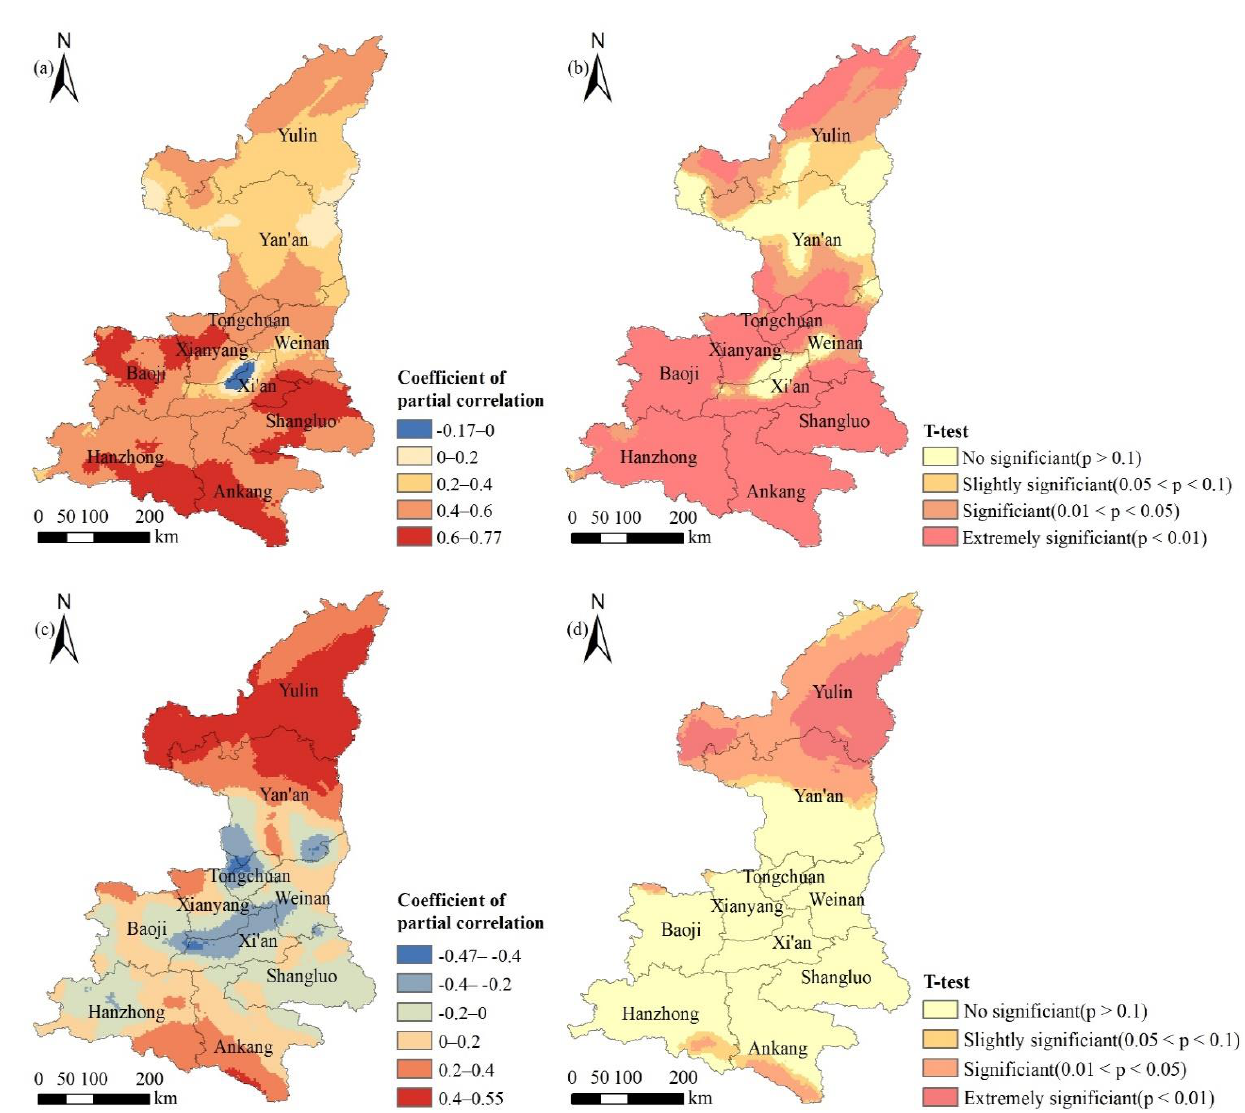
Figure 12. Spatial distribution of the partial correlation coefficients and its t -test results between NDVI and temperature ( a ): coefficient of partial correlation; ( b ): t -test result, precipitation; ( c ): coefficient of partial correlation; ( d ): t -test result in Shaanxi Province.